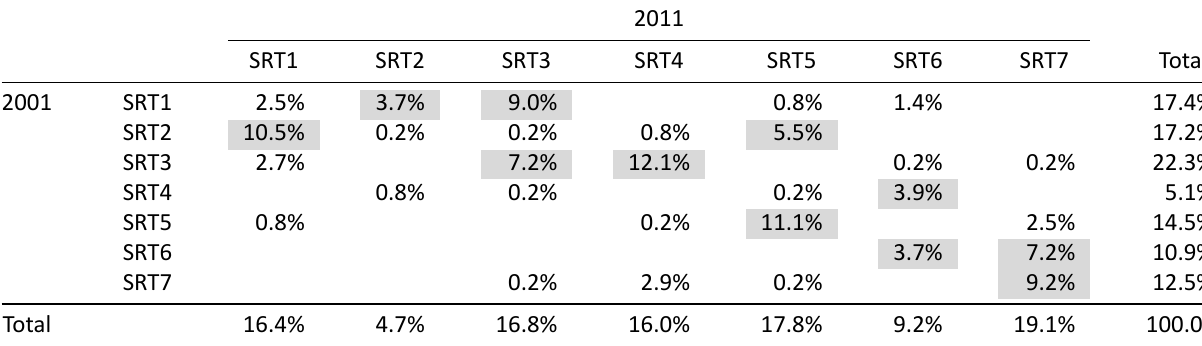
Table 4. Percentage of ATUs according to their SRT in 2001 and